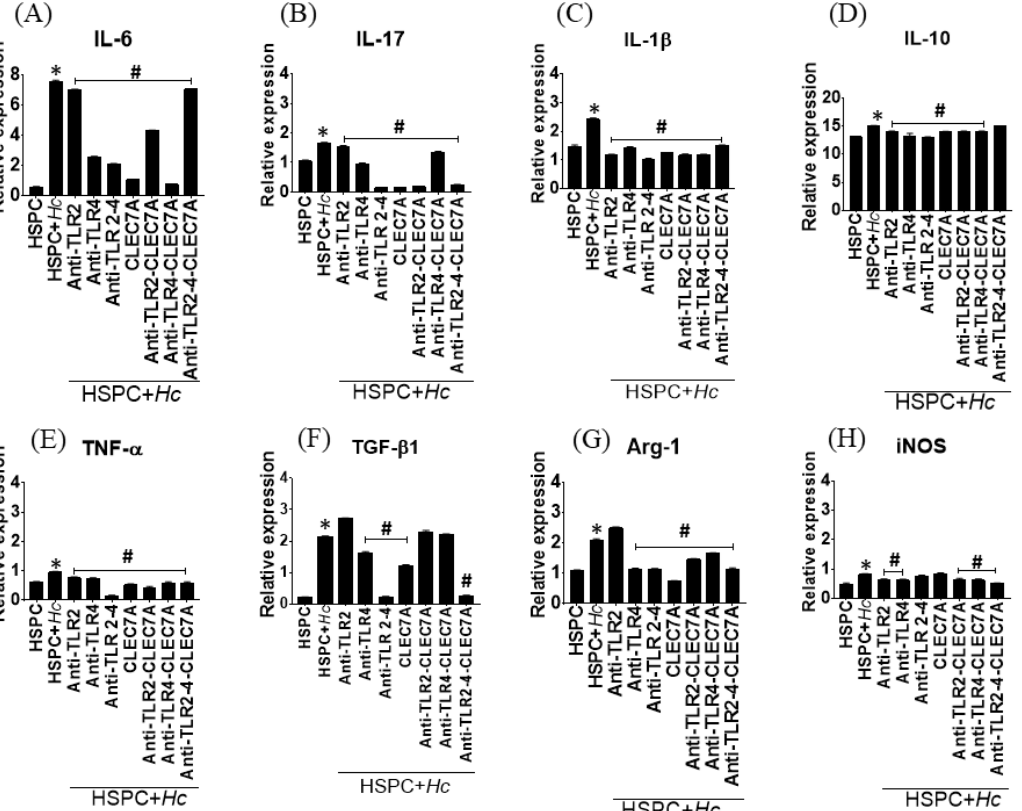
Figure 5. Expression of cytokines and inflammatory mediators in HSPC stimulated with H. capsulatum yeast. Analysis of mRNA expression of proinflammatory cytokines, arginase ‐ 1, and iNOS in HSPC stimulated or not stimulated with H. capsulatum yeast. ( A ) IL ‐ 6; ( B ) IL ‐ 17; ( C ) IL ‐ 1 β ; ( D ) IL ‐ 10; ( E ) TNF ‐α ; ( F ) TGF ‐β 1; ( G ) Arg ‐ 1; and ( H ) iNOS. HSPC, control, unstimulated cells; HSPC + Hc, cells stimulated with H. capsulatum ; TLR, Toll ‐ like receptor; CLEC7A, peptide blocker specific for Dectin ‐ 1. Results are expressed as means ± SD of pooled data from three independent experiments;